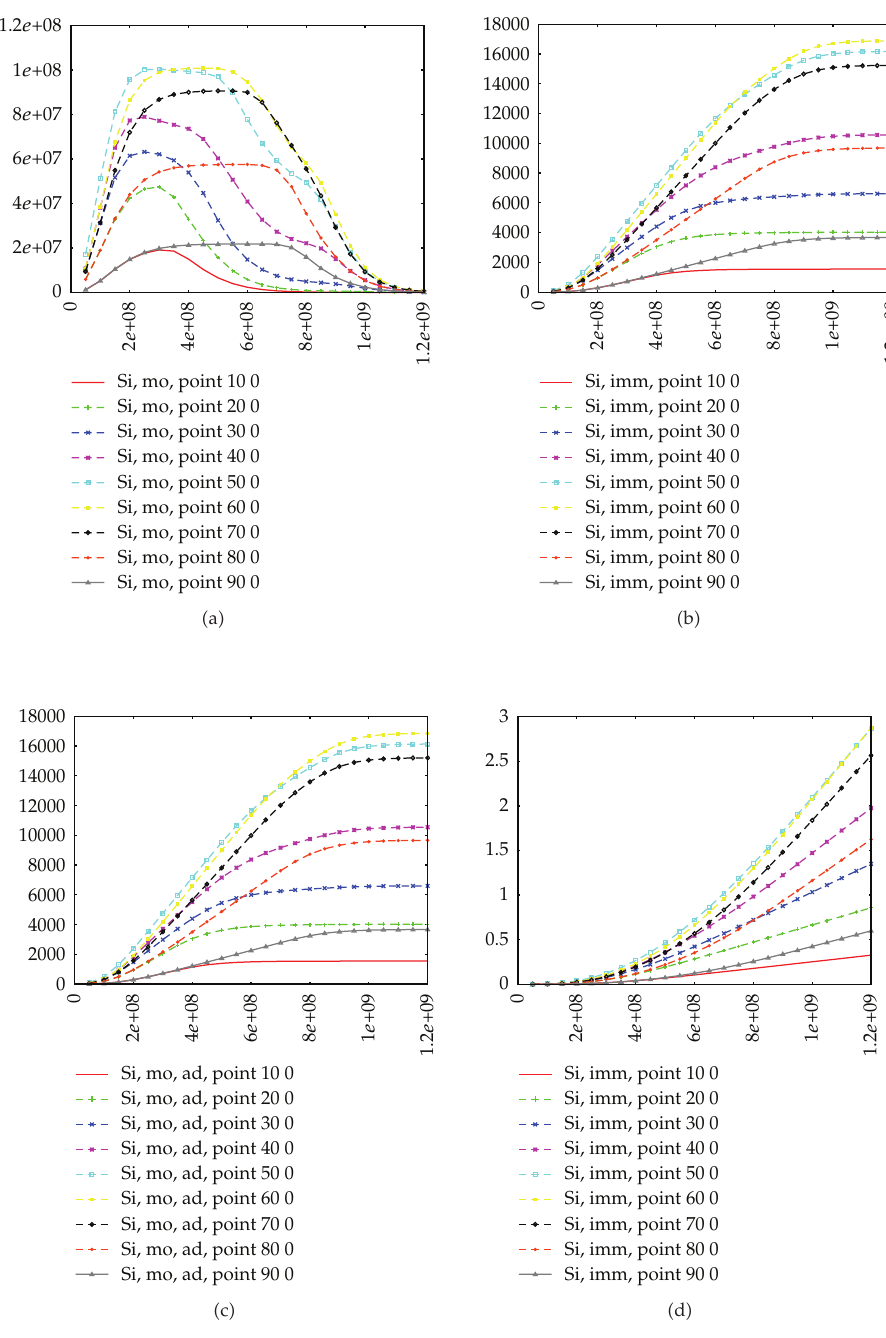
Figure 11: Deposition rates in four phases: mobile (cid:2) a (cid:3) , immobile (cid:2) b (cid:3) , mobile-adsorbed (cid:2) c (cid:3) , immobile- adsorbed (cid:2) d (cid:3) concentration of 11 moving sources moving, (cid:2) x -axis: time scale in (cid:2) nsec (cid:3) , y -axis: deposition rate in (cid:2) mol/nsec (cid:3)(cid:3)